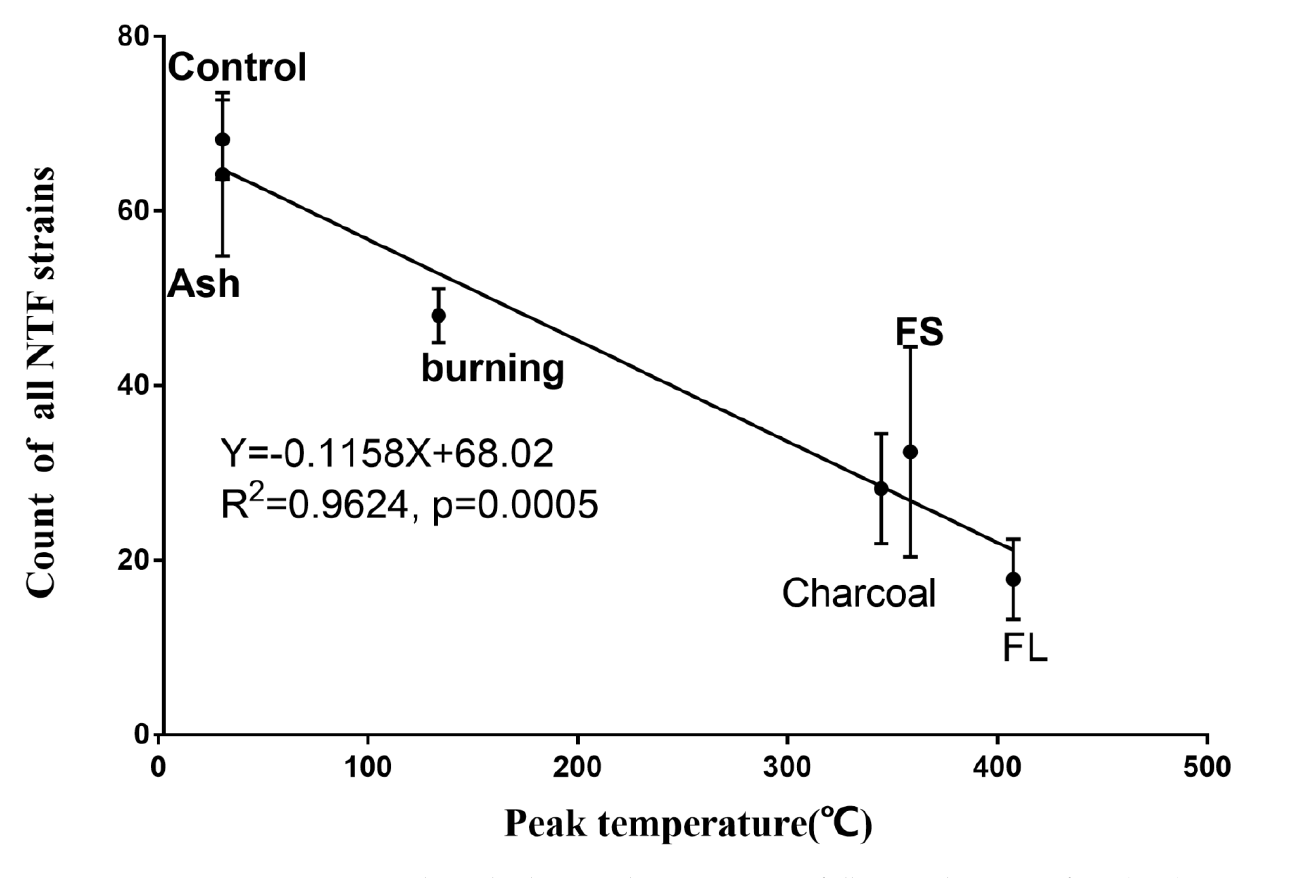
Figure 2. Relationship between the average count of all nematode-trapping fungi (NTF) strains in each treatment and peak temperature.